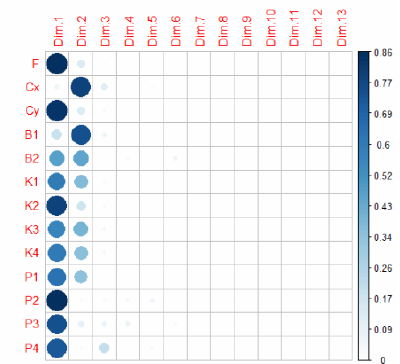
Figure 4. Correlation plot between camera calibration paramaters and principal components extracted by processing the dataset acquired in December. F: focal length; Cx and Cy coordinates of the principal point offset; B 1 , B 2: Skew parameters; k1, k2, k3, k4: radial distortions; p1, p2, p3, p4: